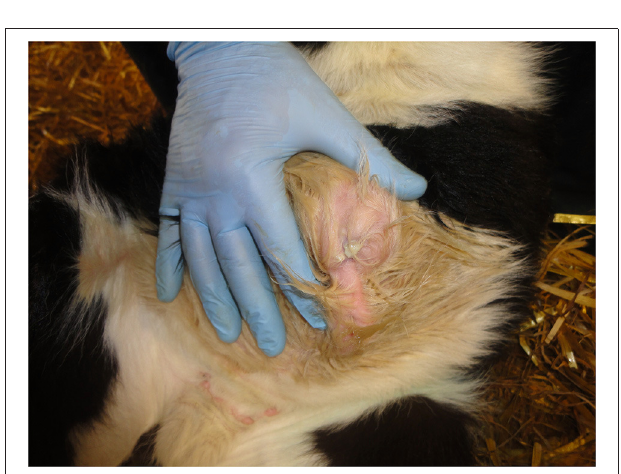
FIGURE 8 | Infection of the umbilicus (navel ill).